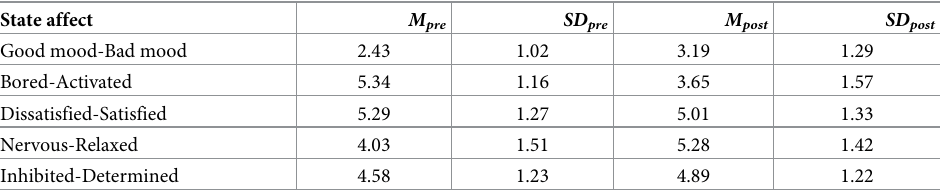
Table 11. CONNECT zero-acquaintance experiment: State affect and self